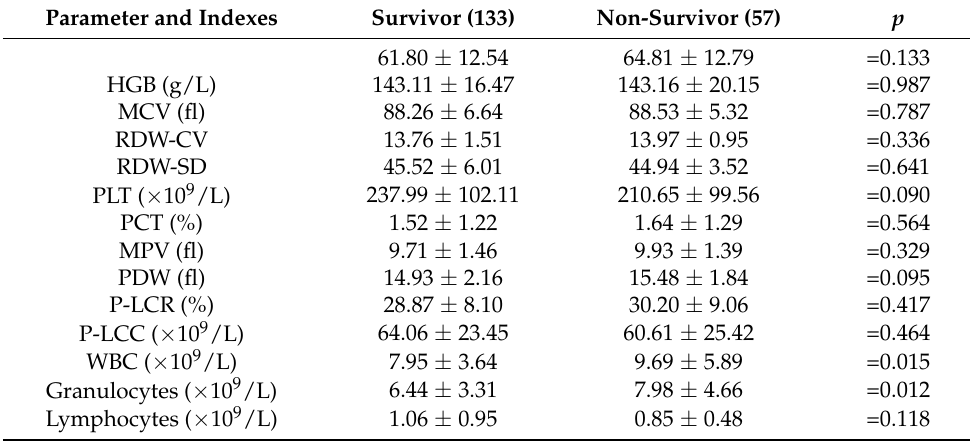
Table 3. Comparison of age and laboratory parameters with standard deviation between survivor and non-survivor